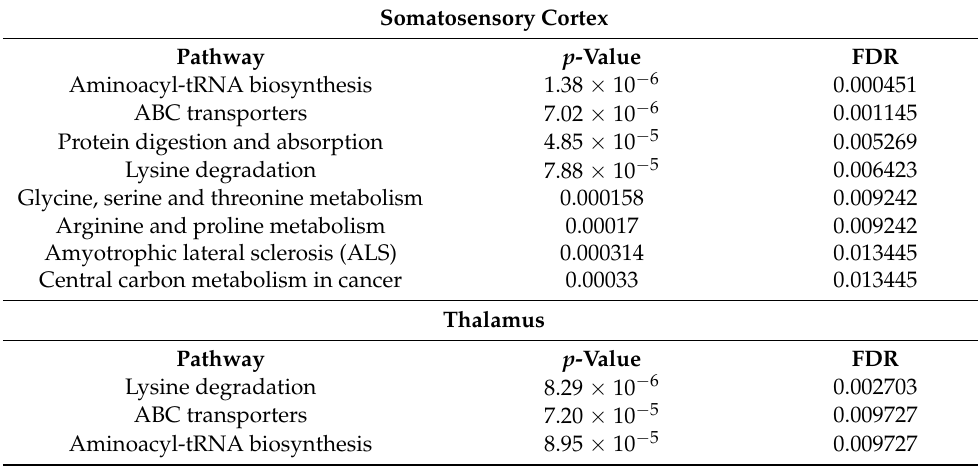
Table 3. The significantly enriched pathways identified in the Blue seizure-associated module in somatosensory cortex and